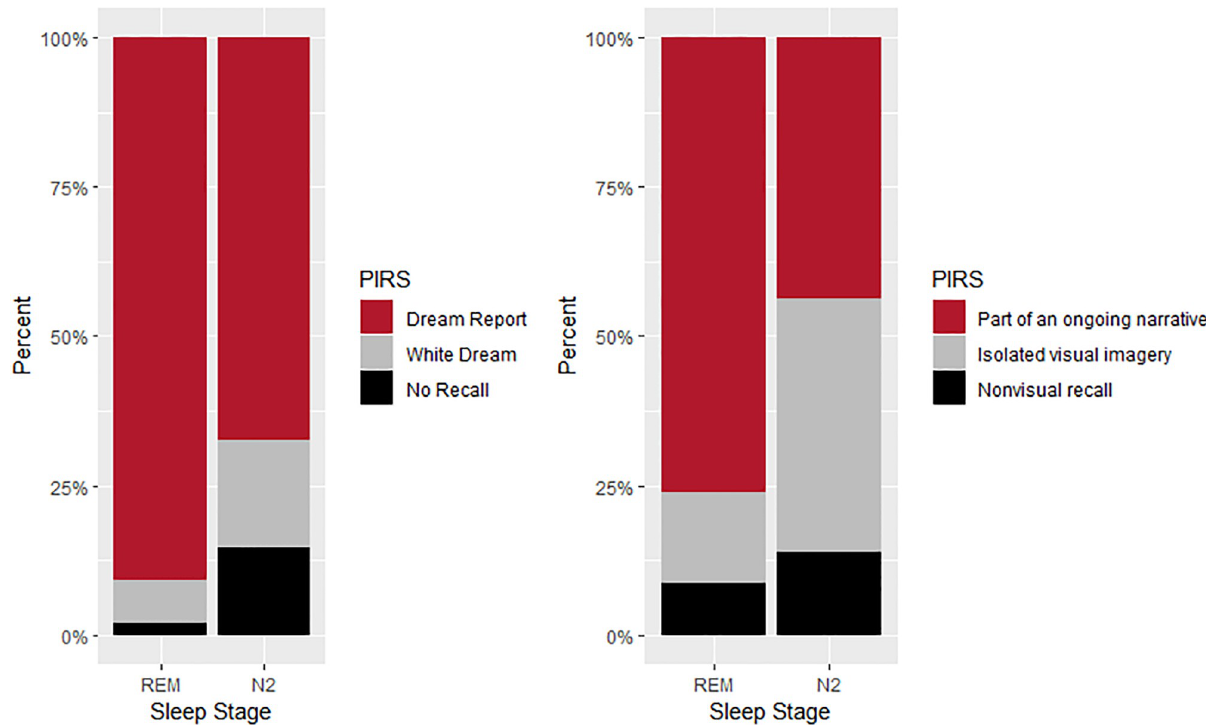
Fig 4. Stacked bar plot showing prevalence of dream reports and type of mentation recalled.